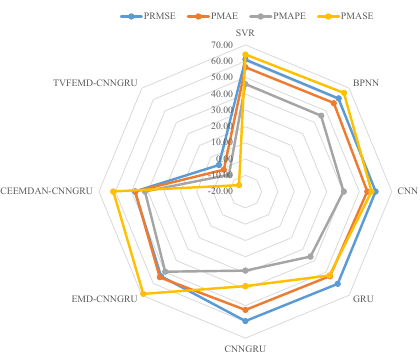
Figure 13. Visualization of all the metric decline ratios.